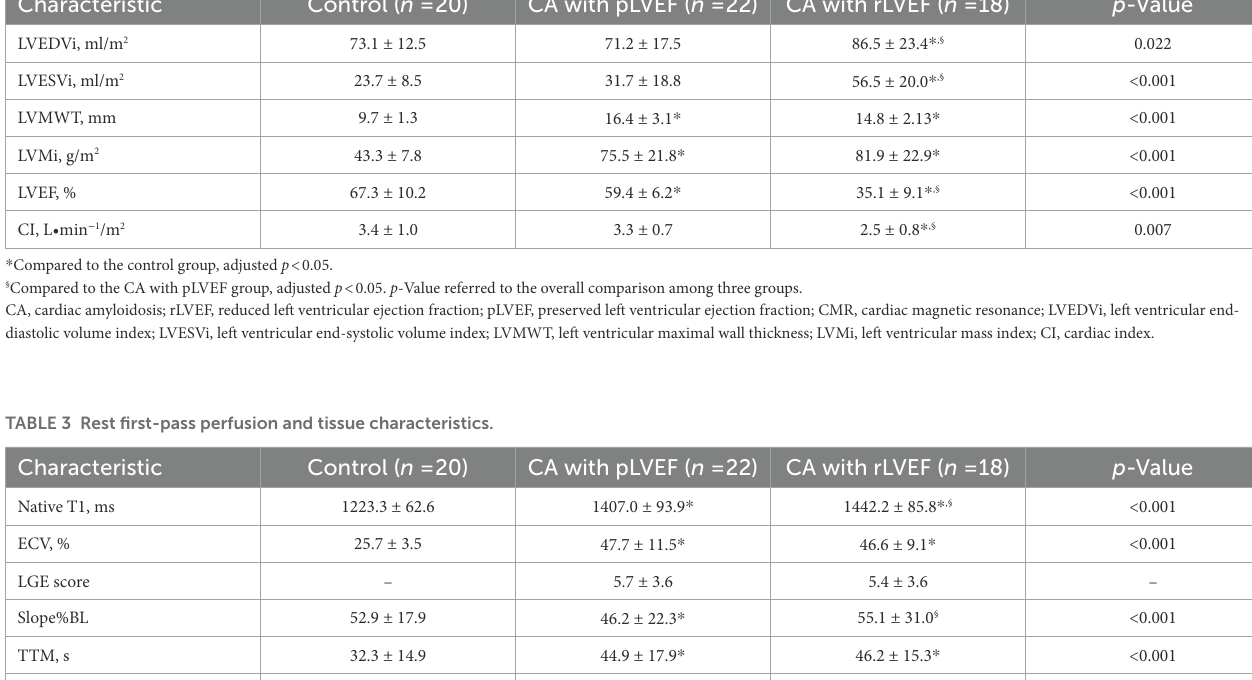
TABLE 2 Morphologic and functional CMR data of all study groups. Characteristic